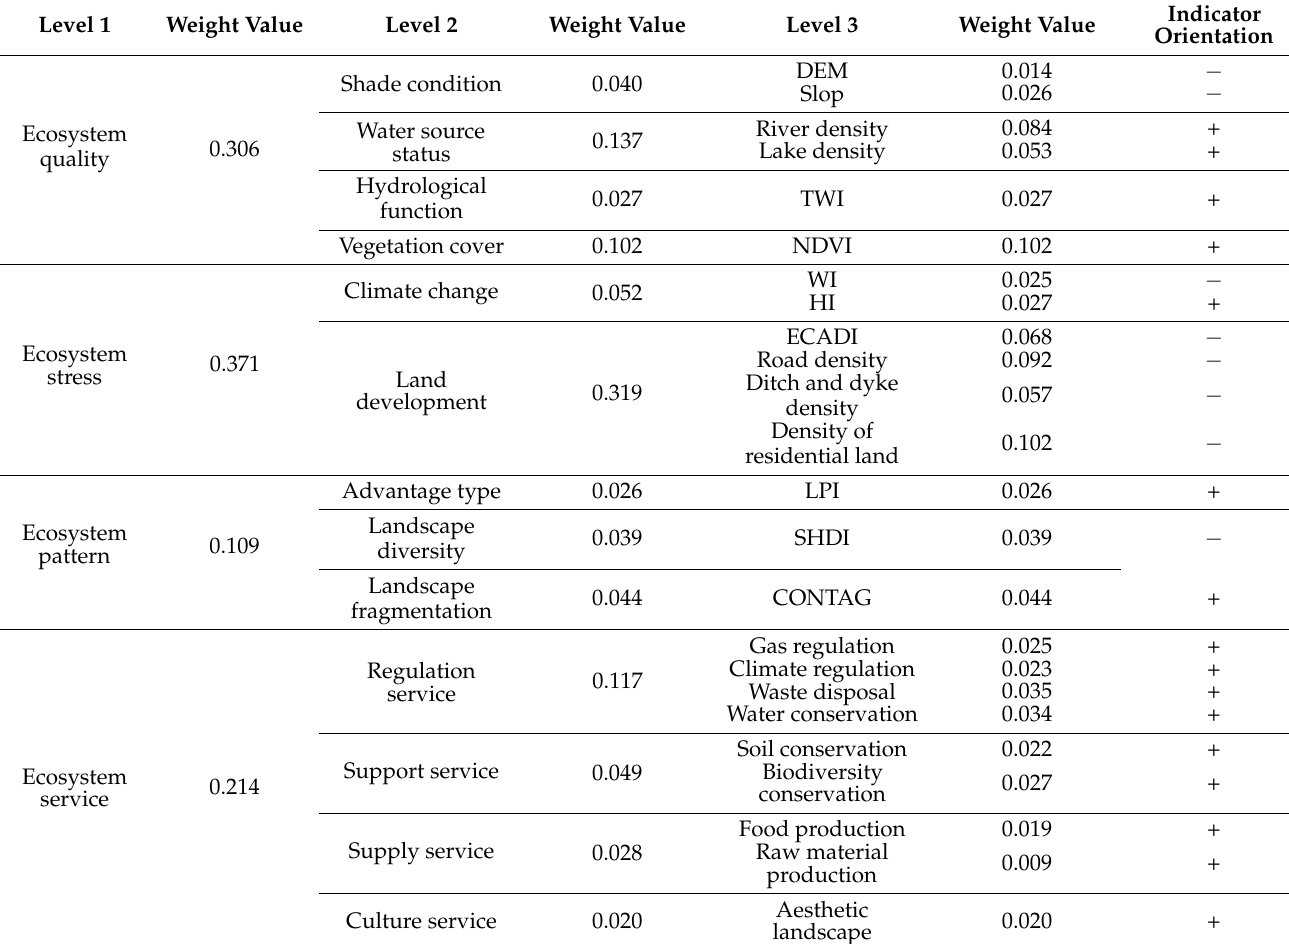
Table 6. “Quality-Pressure-Pattern-Service” ecosystem integrity evaluation factor weighting table.